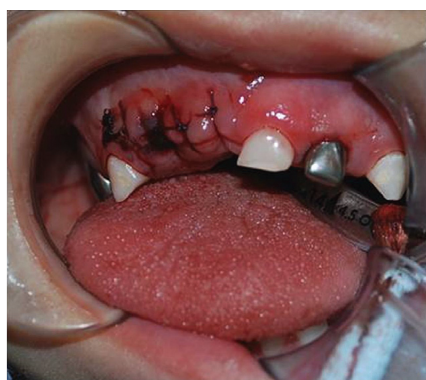
Figure 3: View of the